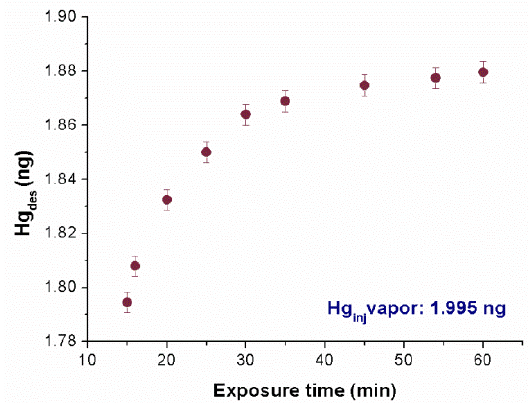
Figure 7. Adsorption curve of a known amount of injected Hg 0 vapors (C: 0.235 ng/mL) versus exposure times ranging between 15 and 60 min.